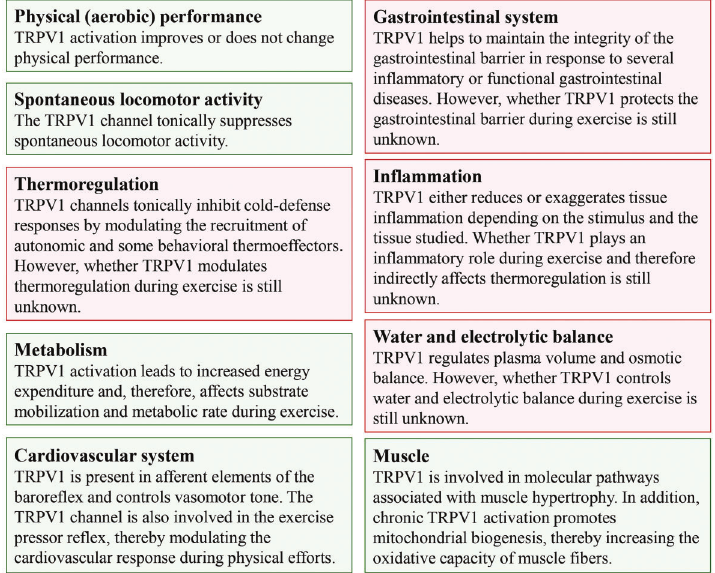
Figure 3. Overview of the physiological functions exerted by transient receptor potential vanilloid type 1 (TRPV1) channels. The green boxes indicate responses that are mediated by TRPV1 channels during physical activity or exercise, whereas the red boxes indicate TRPV1-mediated physiological responses that have not been investigated under such